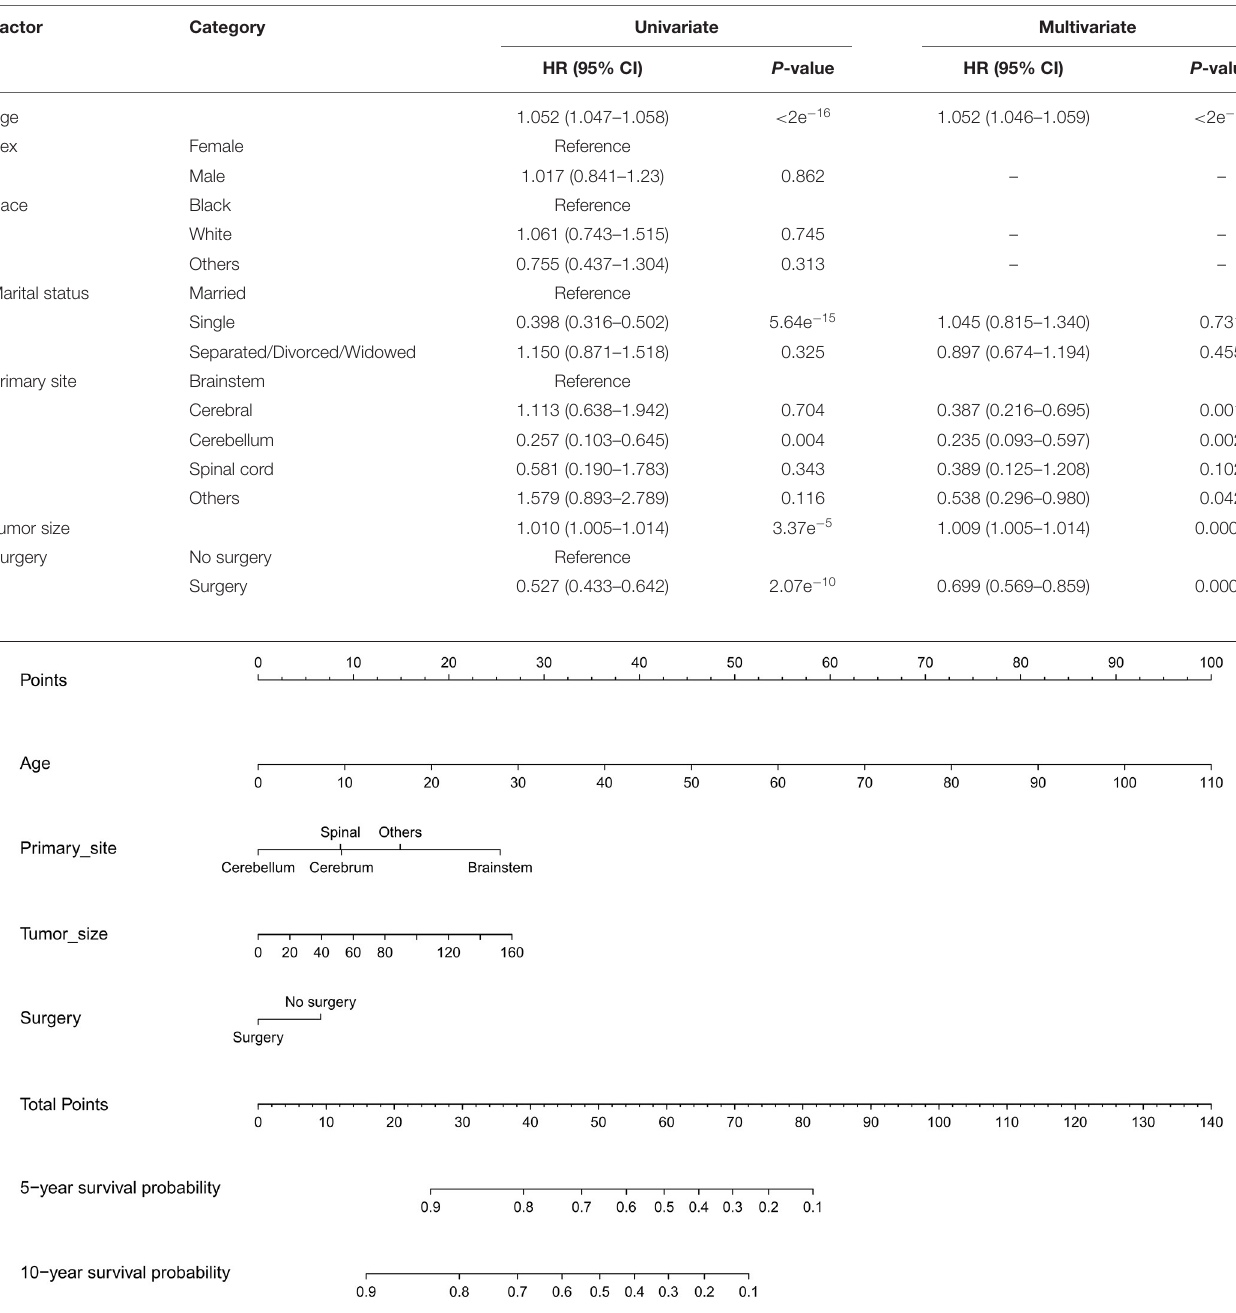
TABLE 2 | Univariate and multivariate Cox proportional hazard analyses of clinical characteristics for cancer-specific survival rates. Factor